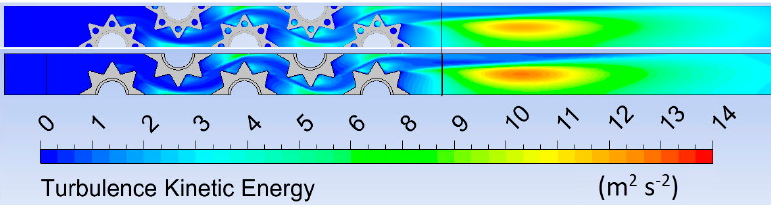
Figure 8. Turbulence kinetic energy fields for perforated and non-perforated fins.